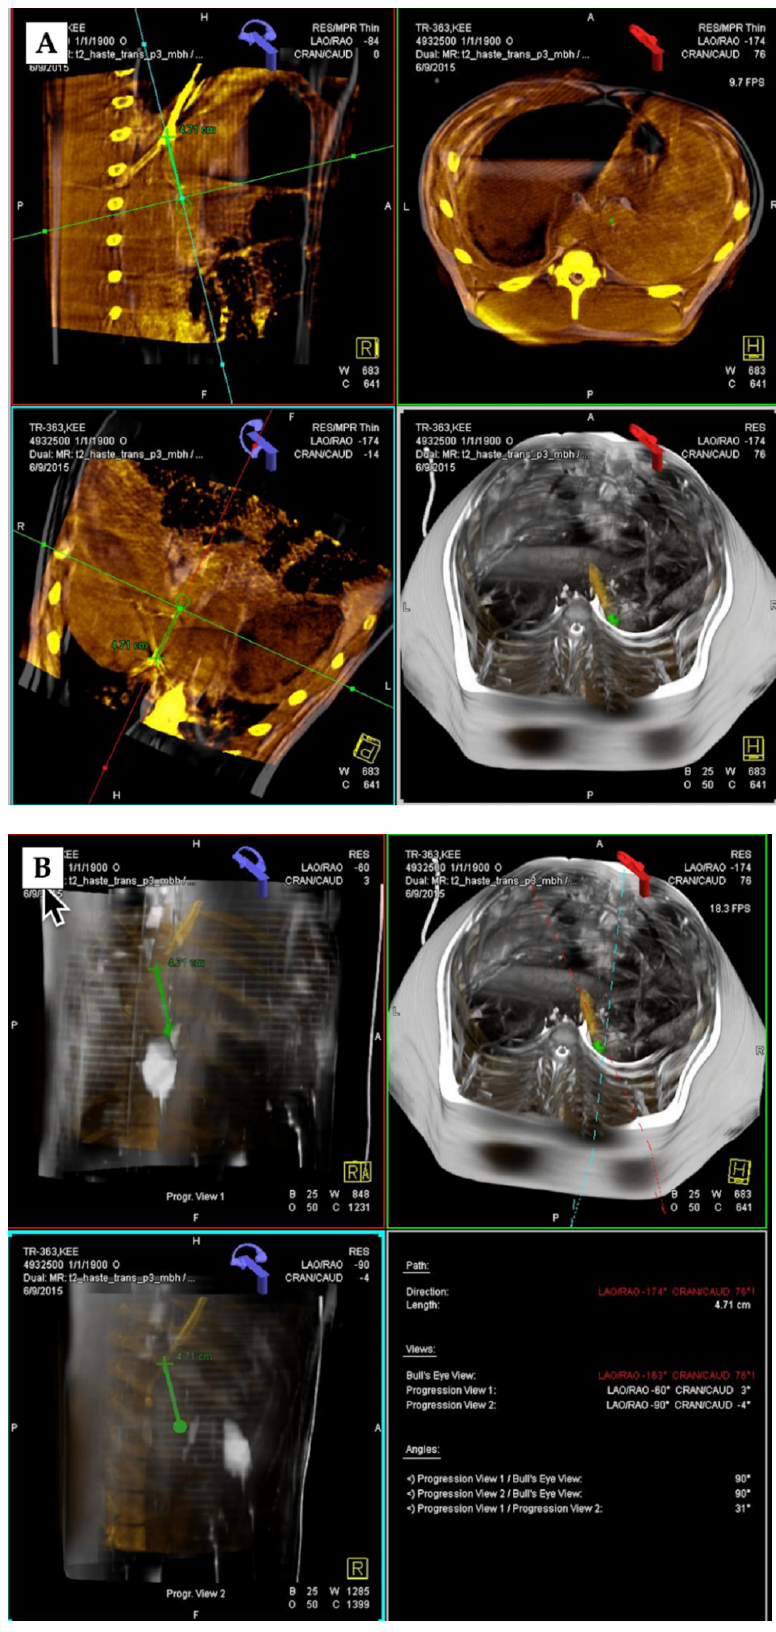
Figure 2. 3D Fusion Processing: ( A ) screenshots of the image software that was used to produce the three-dimensional fusion images of the pre-procedural MRs (yellow images) and